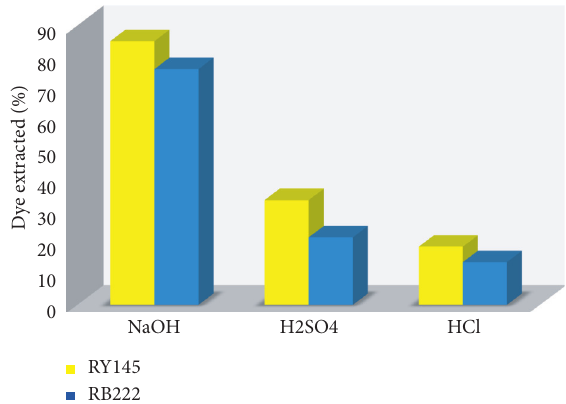
Figure 19: Effect of stripping reagents on extracted RB222 and RY145.